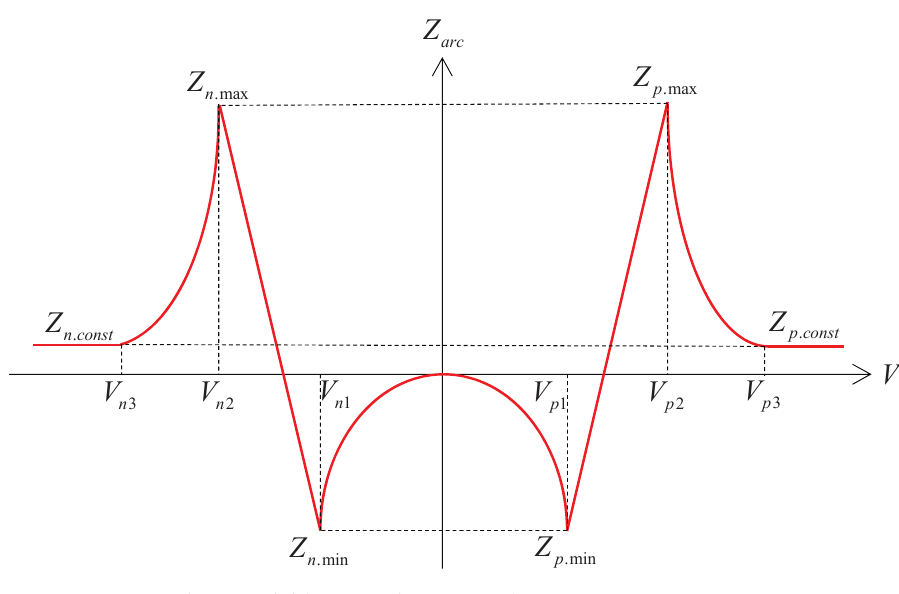
Figure 6. Proposed arc model (proposed Z–V curve).